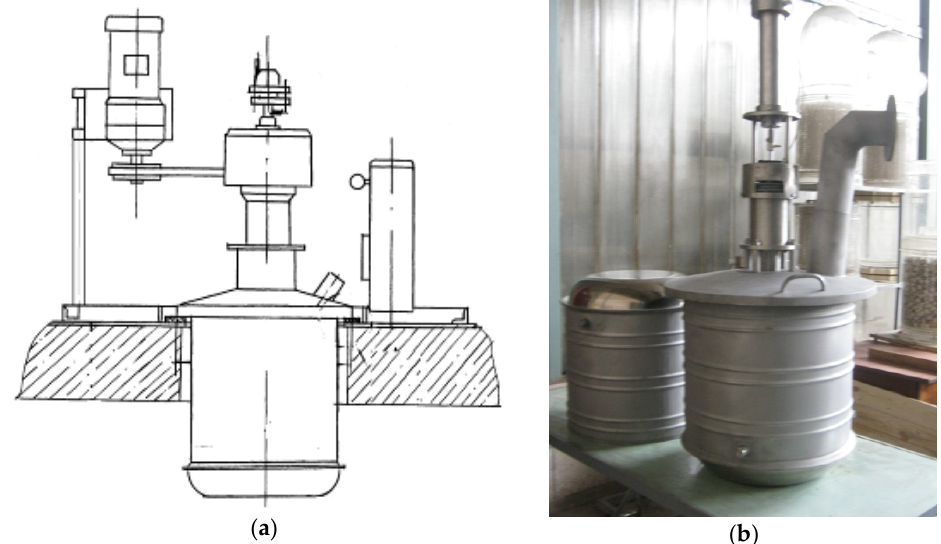
Figure 7. Rotating vibratory priller: ( a ) schematic diagram; ( b ) photo.